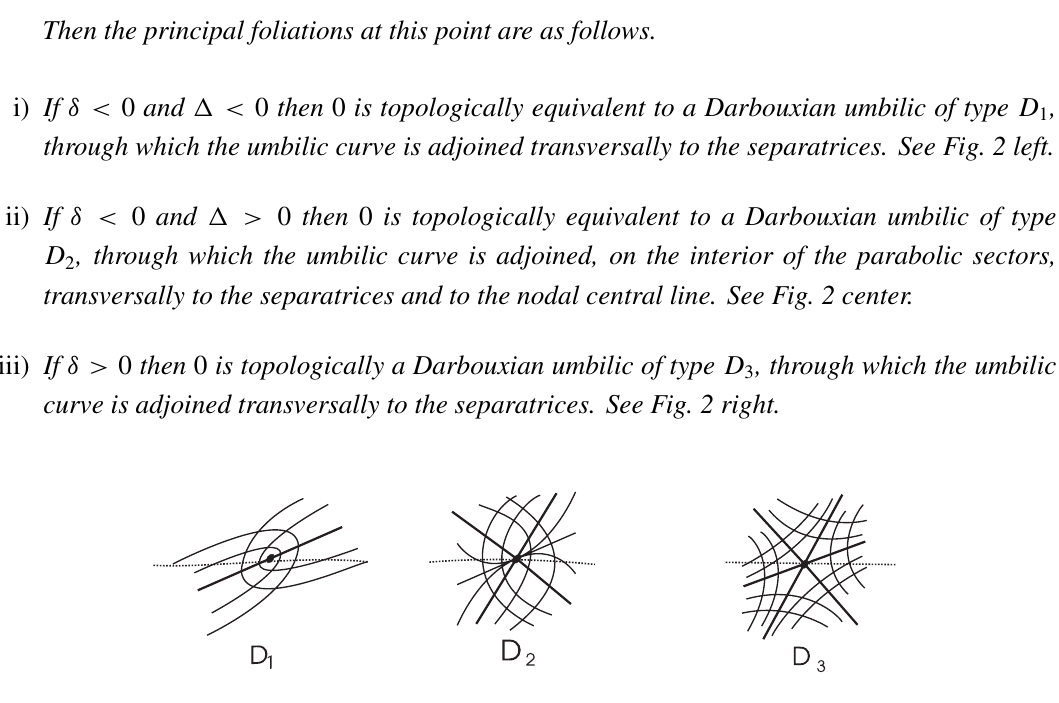
Fig. 2 – Principal curvature lines near a Darbouxian-like point on an umbilic curve,